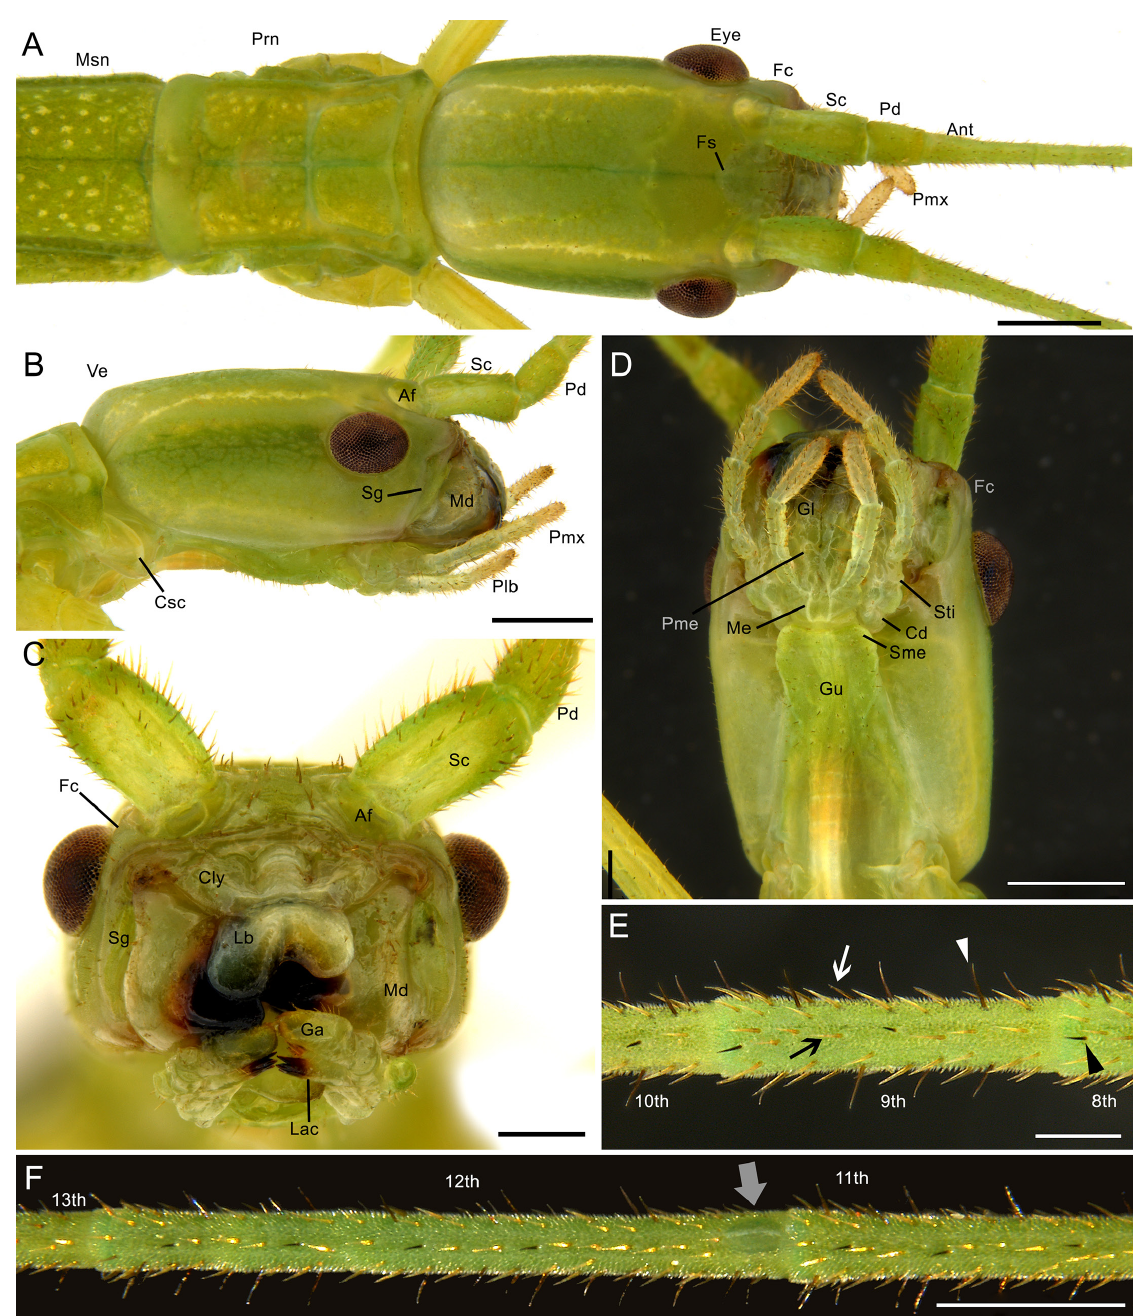
Fig. 3. Head morphology of Arumatia dubia (Caudell, 1904) gen. et comb. nov., adult ♀ (MZUSP V0542) from stock from Ibaté, São Paulo, Brazil. A . Head in dorsal view. B . Head in lateral view. C . Head in anterior view. D . Head in ventral view. E . Antennomeres showing three types of setae: very short densely distributed setae (covering the surface area), stiff and straight setae (arrowheads) and porrect transparent setae (arrows). F . Antennomeres showing antennal bump (arrow). Abbreviations: Af = antennal field; Ant = antennomere; Cd = cardo; Cly = clypeus; Csc = cervical sclerite; Eye = compound eye; Fc = frontal convexity; Fs = frontal suture; Ga = galea; Gl = glossa; Gu = gula; Lac = lacinia; Lb = labrum; Md = mandible; Me = mentum; Msn = mesonotum; Pd = pedicellus; Plb = labial palpus; Pme = prementum; Pmx = maxillary palpus; Prn = pronotum; Sc = scapus; Sg = subgena; Sme = submentum; Sti = stipes; Ve = vertex. Scale bars: A–B, D = 1 mm; C, F = 0.5 mm; E = 0.2